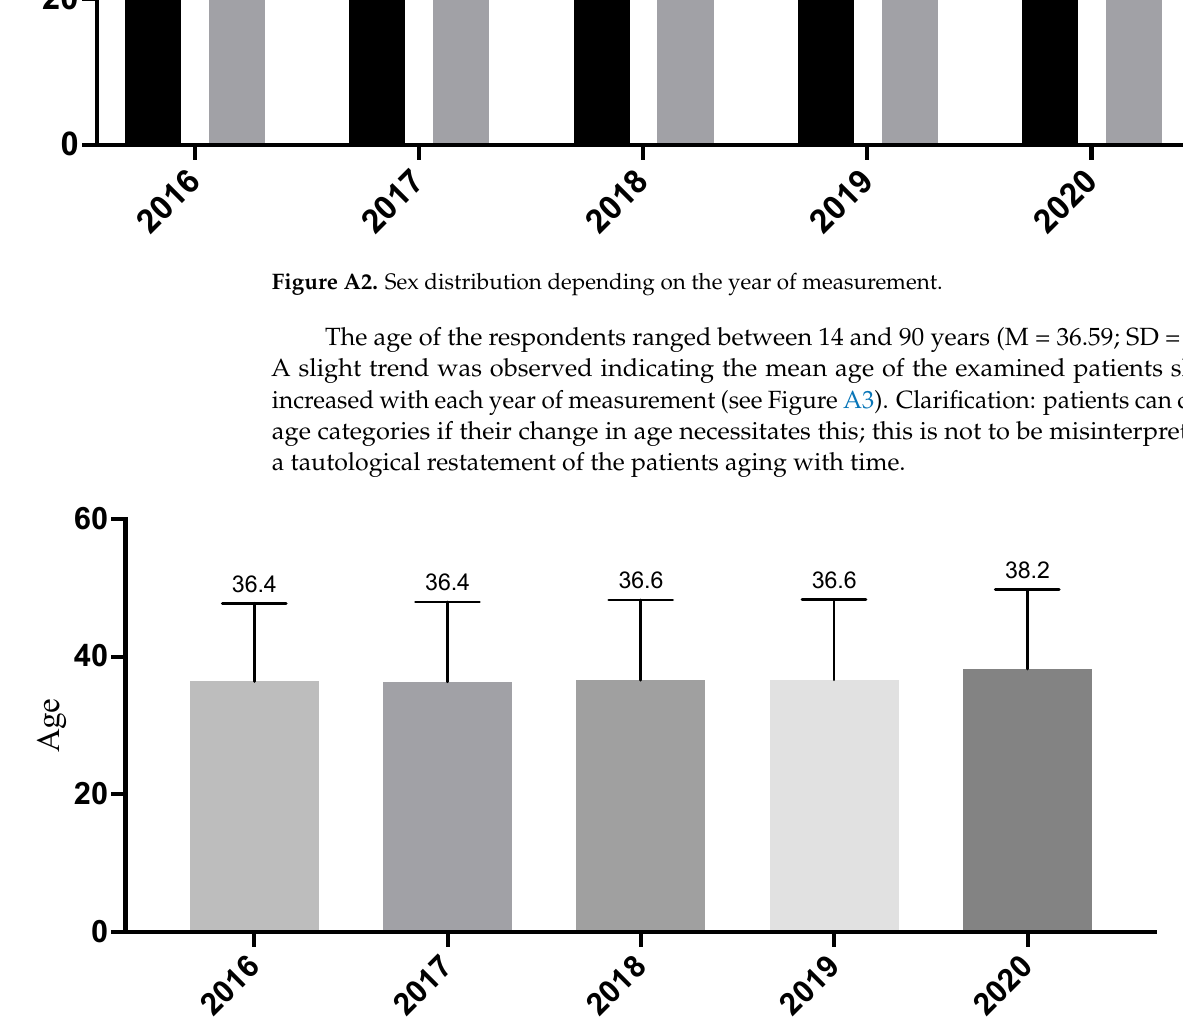
Figure A3. Patient age distribution versus the year of measurement. The exact distribution of age groups depending on the year of measurement is pre- sented in the table below. It was found that, with successive years of measurement, a decreased percentage of people aged 18–35 and an increased percentage in the age group 35–54 were observed. In the case of the remaining age groups, the trends were not as clear as in the case of these two age